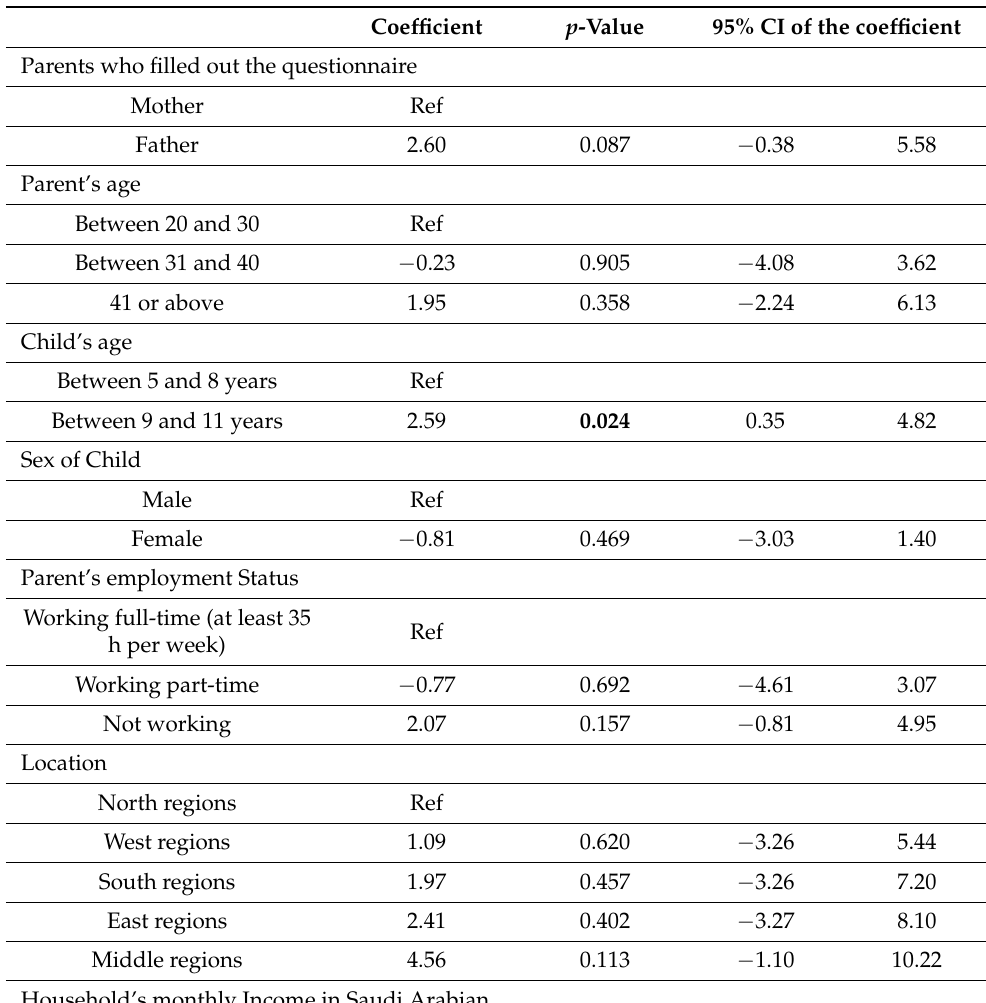
Table 3. Multiple linear regressions for the factors associated with parents’ attitude towards vaccina- tion. Bold means